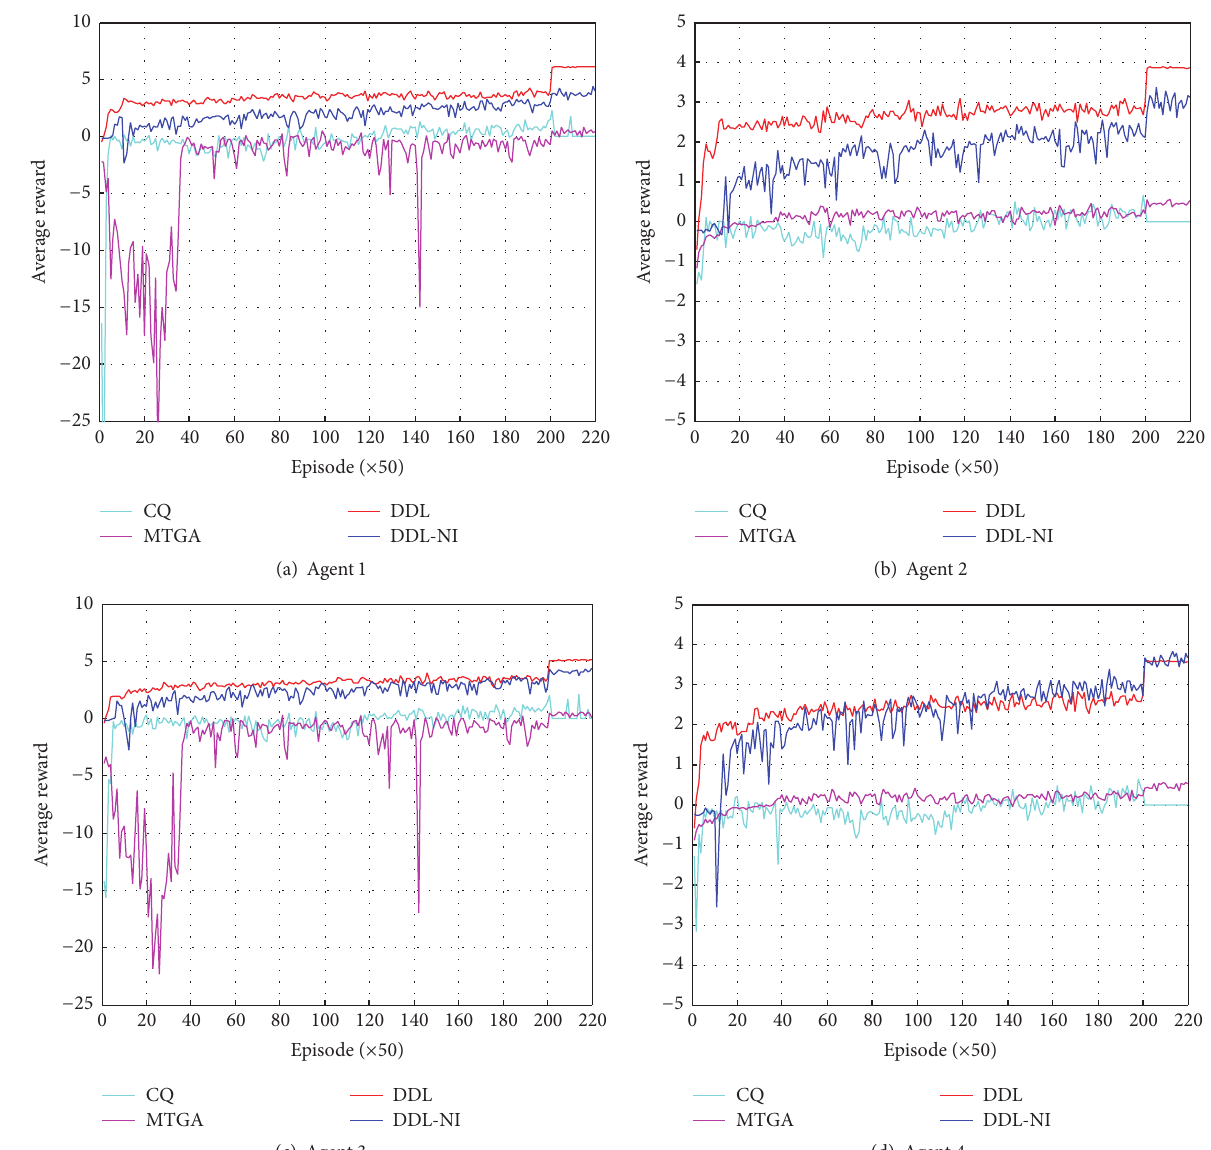
Figure 8: The learning curves of the tested approaches in game